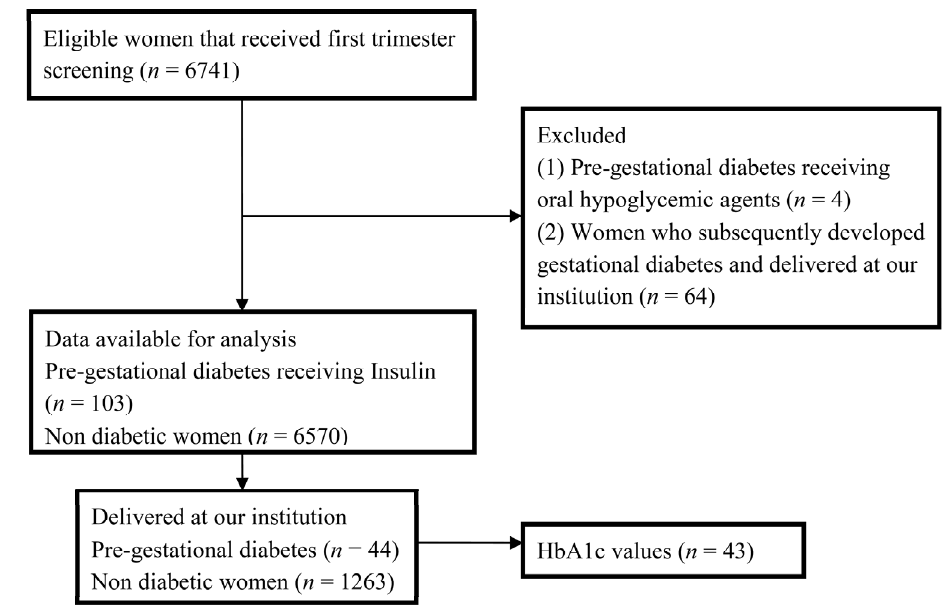
Figure 1. Flow chart of study population.